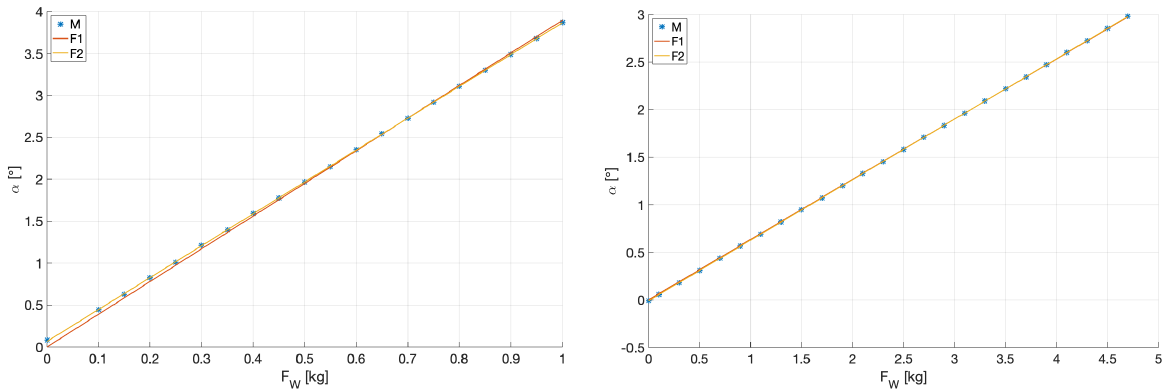
Figure 6. Function SwingF 2: fitting of the points for the analysis cases C1,C2,C4,C5 and difference of the measured value indicated with M to the fitted value F normalised by the measured value—in relation to the calibration weights F W .